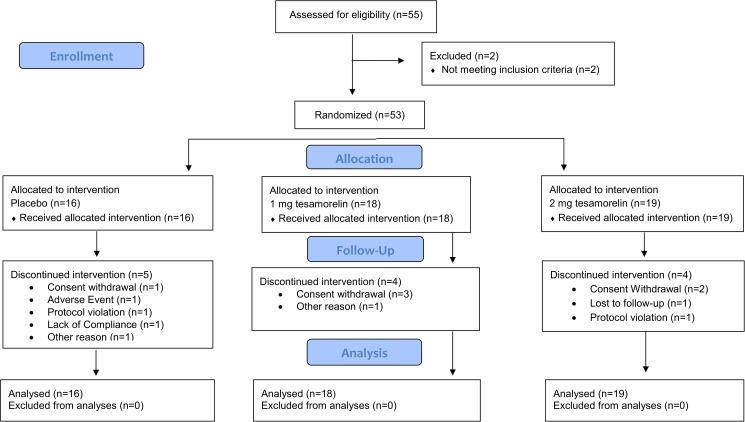
CONSORT flow diagram of the clinical study.Patient enrollment and outcomes.